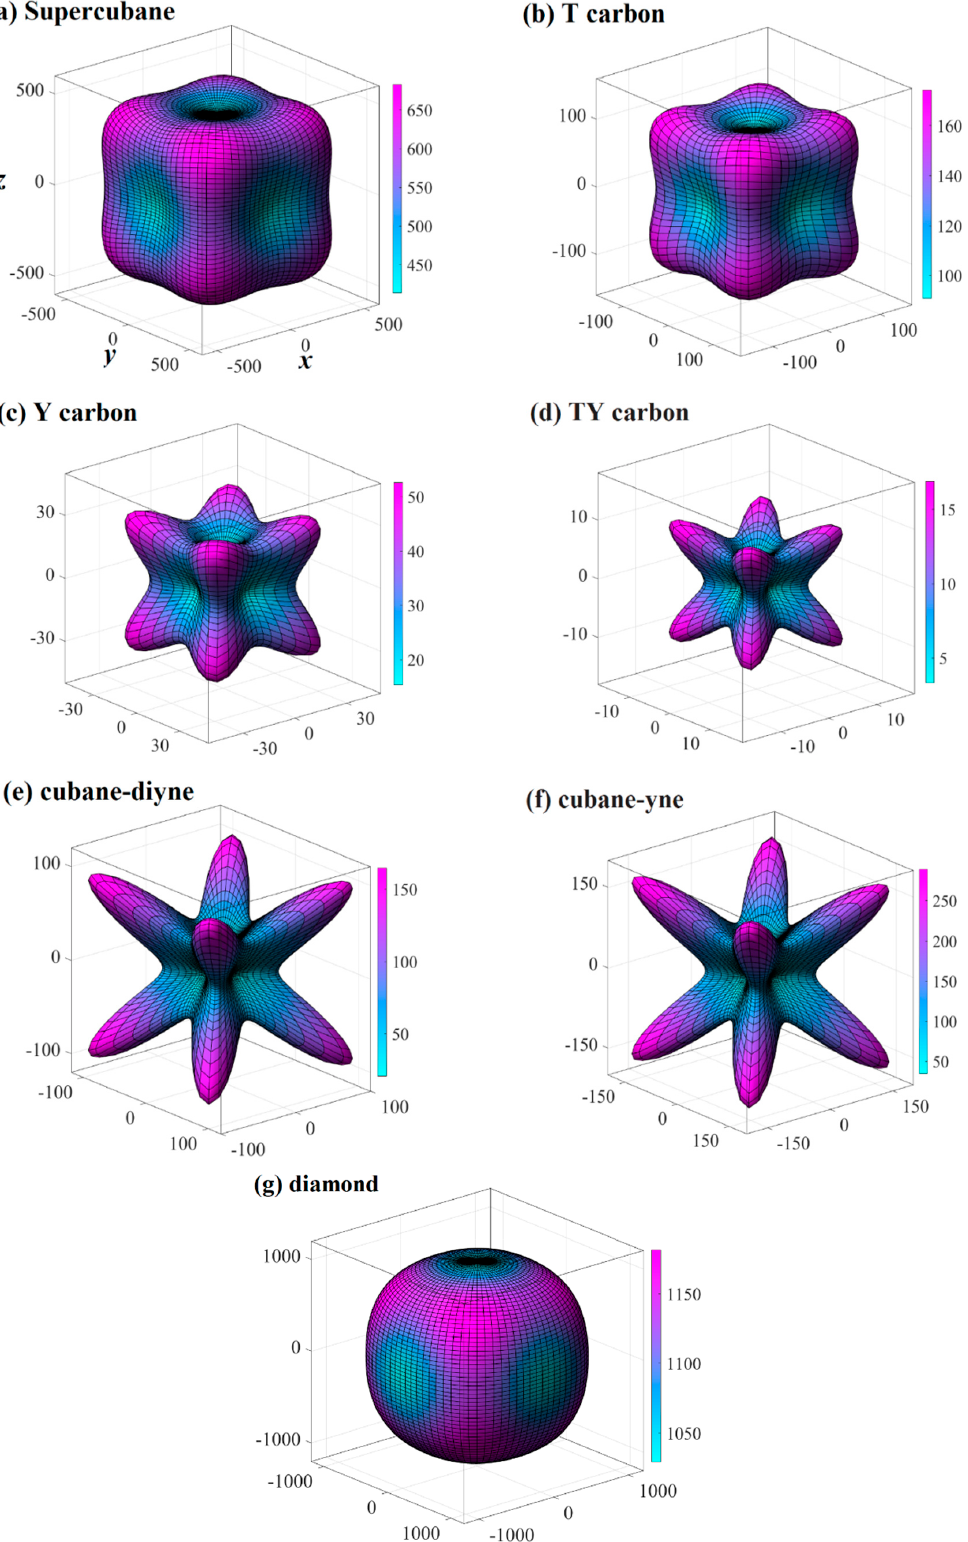
Figure 2. Three-dimensional contour plots of the Young’s modulus for supercubane ( a ), T carbon ( b ), Y carbon ( c ), TY carbon ( d ), cubane-diyne ( e ), cubane-diyne ( f ), and diamond ( g ).